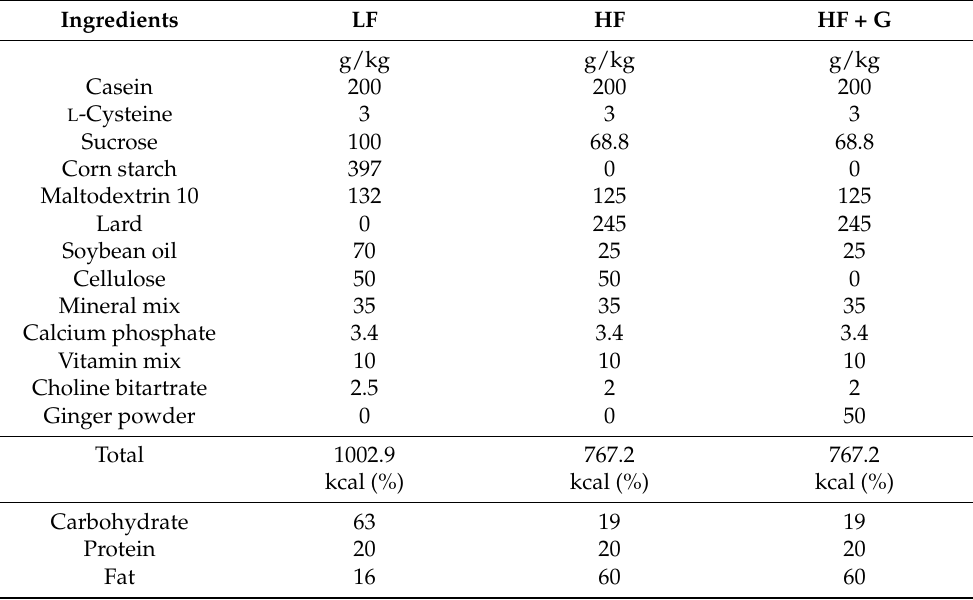
Table 1. Dietary composition of low-fat (LF), high-fat (HF), and HF plus 5% ginger powder (HF + G) diets 1